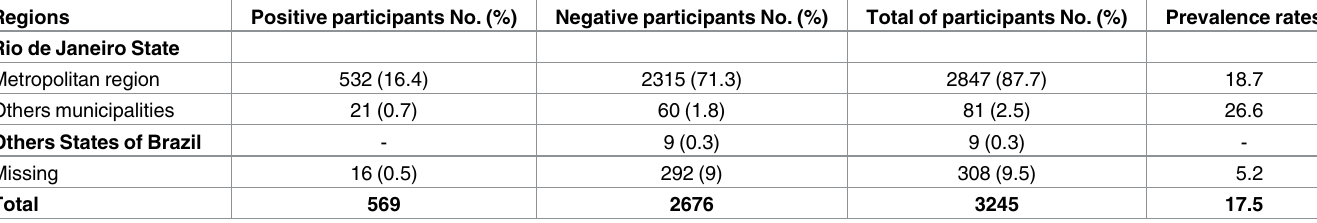
Table 6. Number of positive and negative participants to intestinal parasitesby regions.